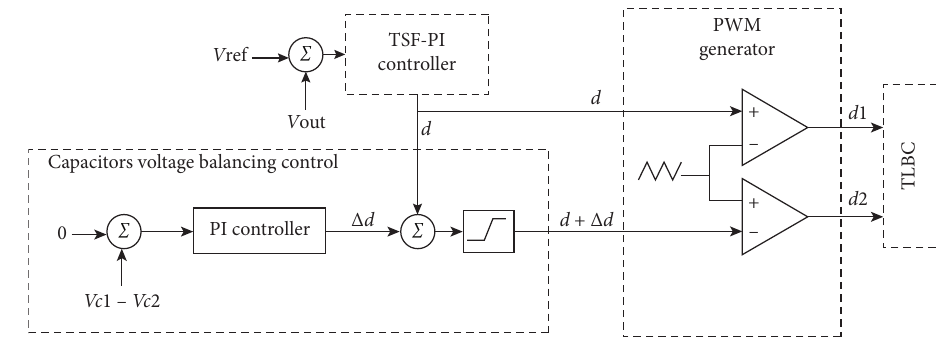
Figure 16: Block diagram of the global proposed control